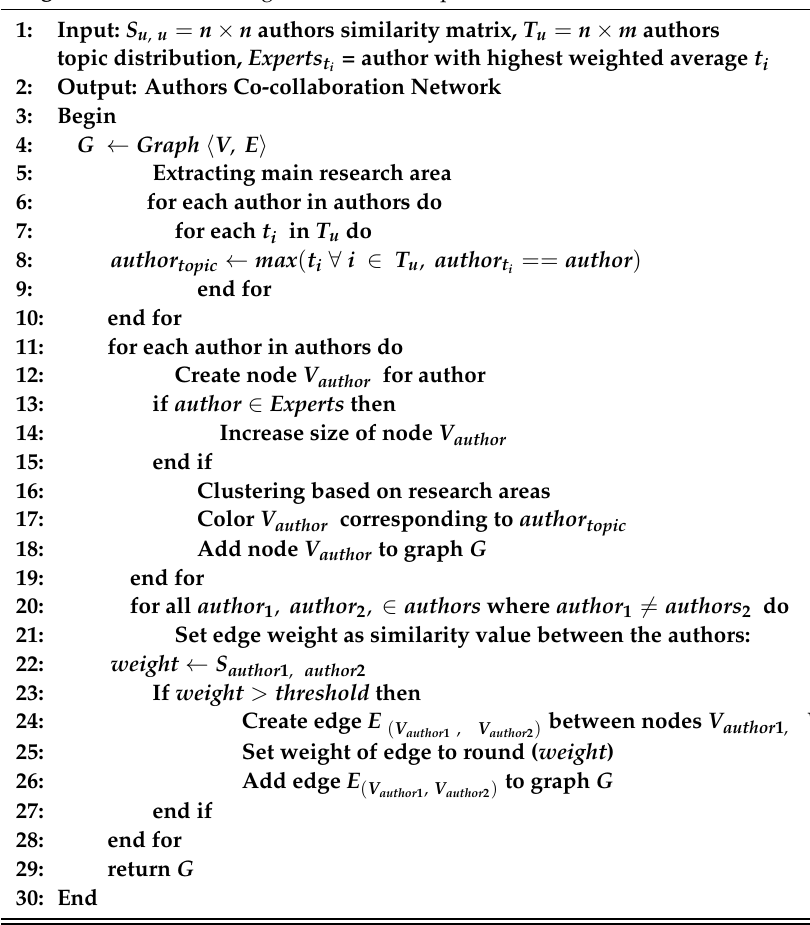
Algorithm A4 Generating an Authors’